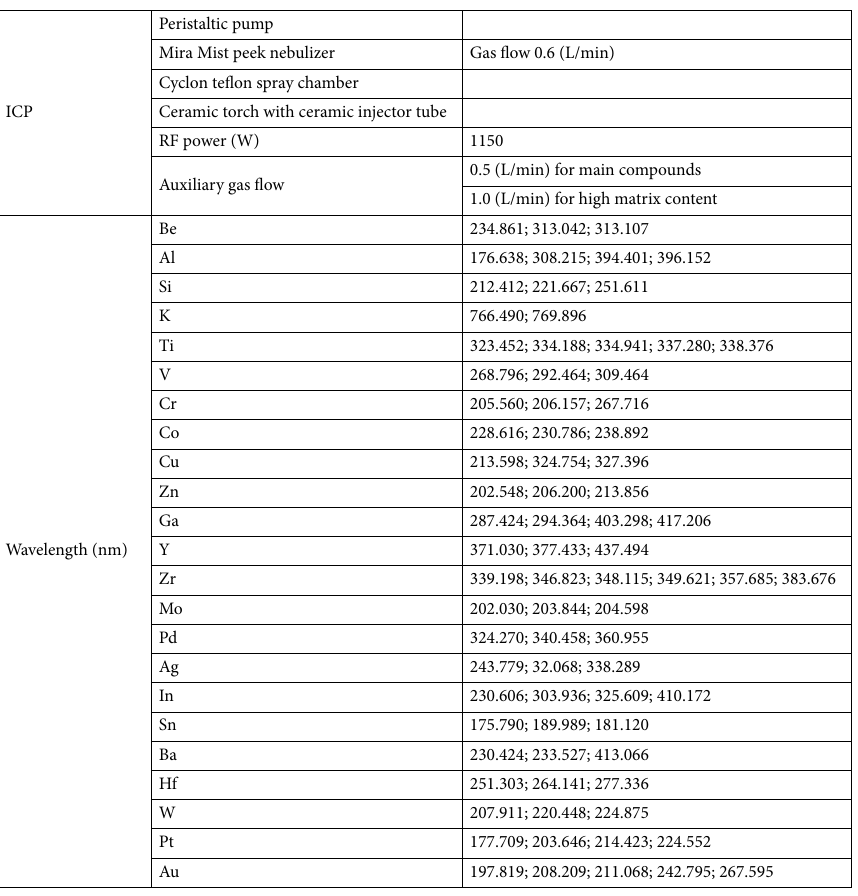
Table 3. Instrument settings for ICP-OES.